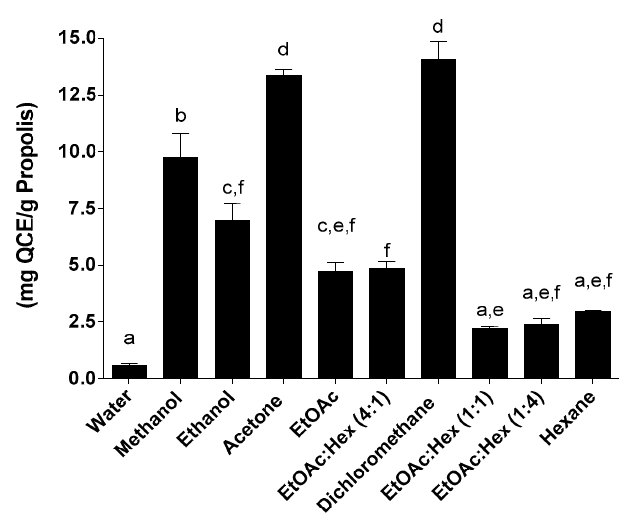
Figure 6. Total flavonoid content following UAE. Values are the means ± SEM of at least three independent experiments, each performed in duplicate; values with different superscripts are significantly different ( p < 0.05) as determined by one-way ANOVA test with subsequent Tukey’s adjustment; QCE: quercetin equivalent.